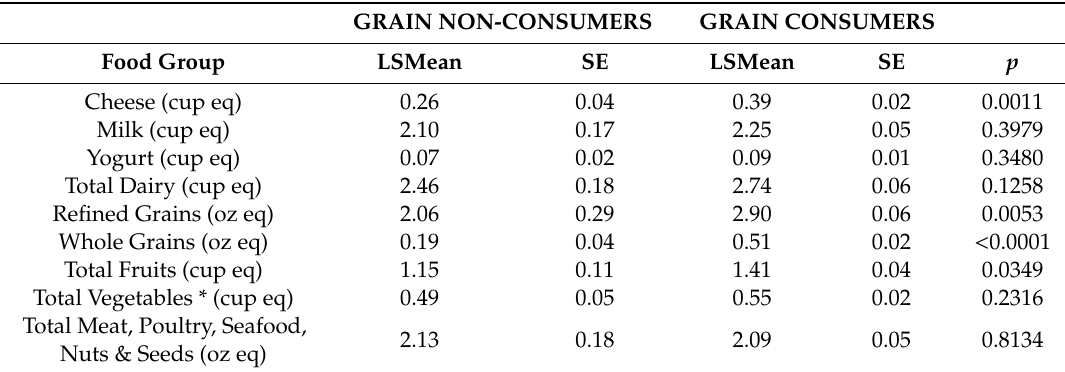
Table 6. Mean (SE) food group intake for 13- to 23-month-old grain consumers vs. grain